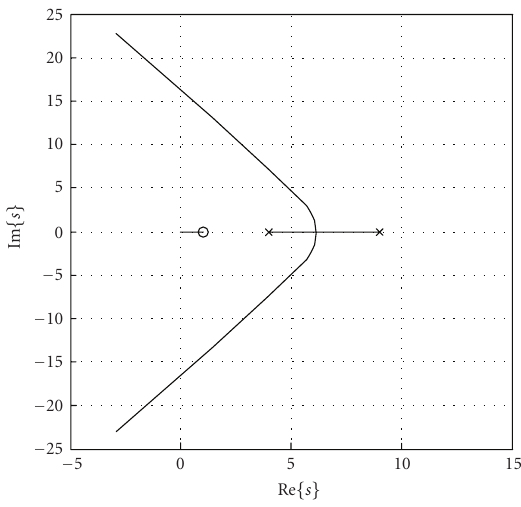
Figure 3: Root-locus plot of Example 4.1.